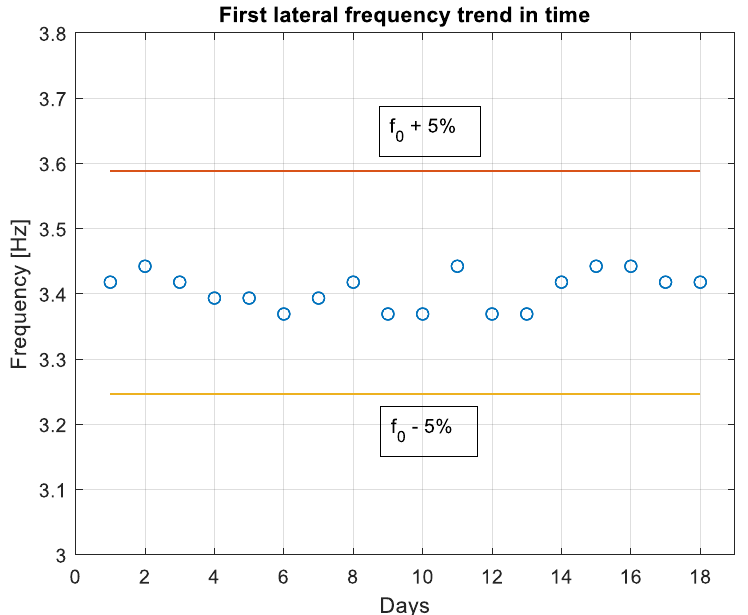
Figure 12. Trend of the first lateral mode natural frequency in time. The slight difference in the identified values allow the use of the variation of this parameter in time as a diagnostic indicator.